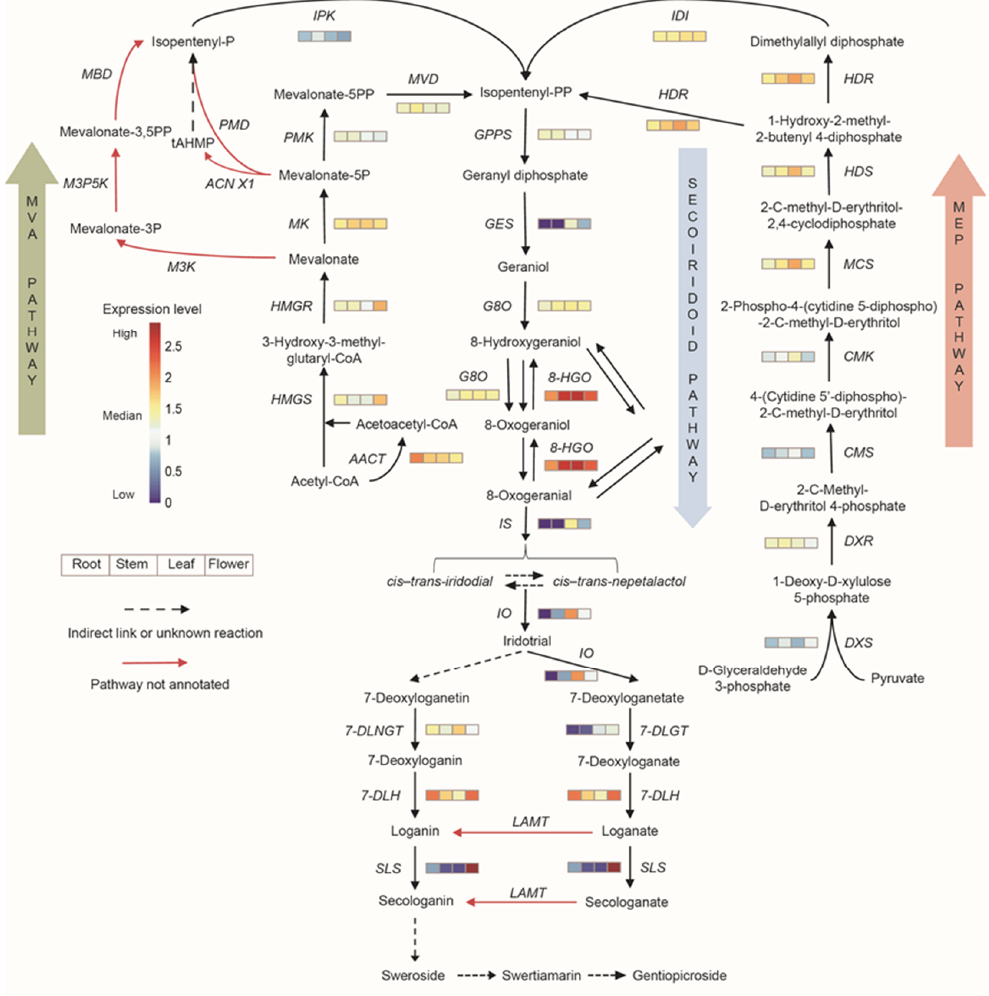
Figure 5. Expression analysis of genes involved in iridoid biosynthesis. Different color blocks represent the normalized gene expression levels (log10 (TPM+1)) in different tissues of G. macrophylla. The blocks from left to right represent roots, stems, leaves, and flowers, respectively. Red: higher expression; blue: lower expression.